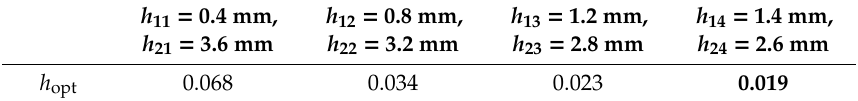
Figure 16. Comparison between simulated magnitude variation of A 0 mode (the magenta solid line) and the predicted variations and different depths and damage length of 90 mm. Table 2. h opt values used as a criterion to estimate the depth of delamination in 3D